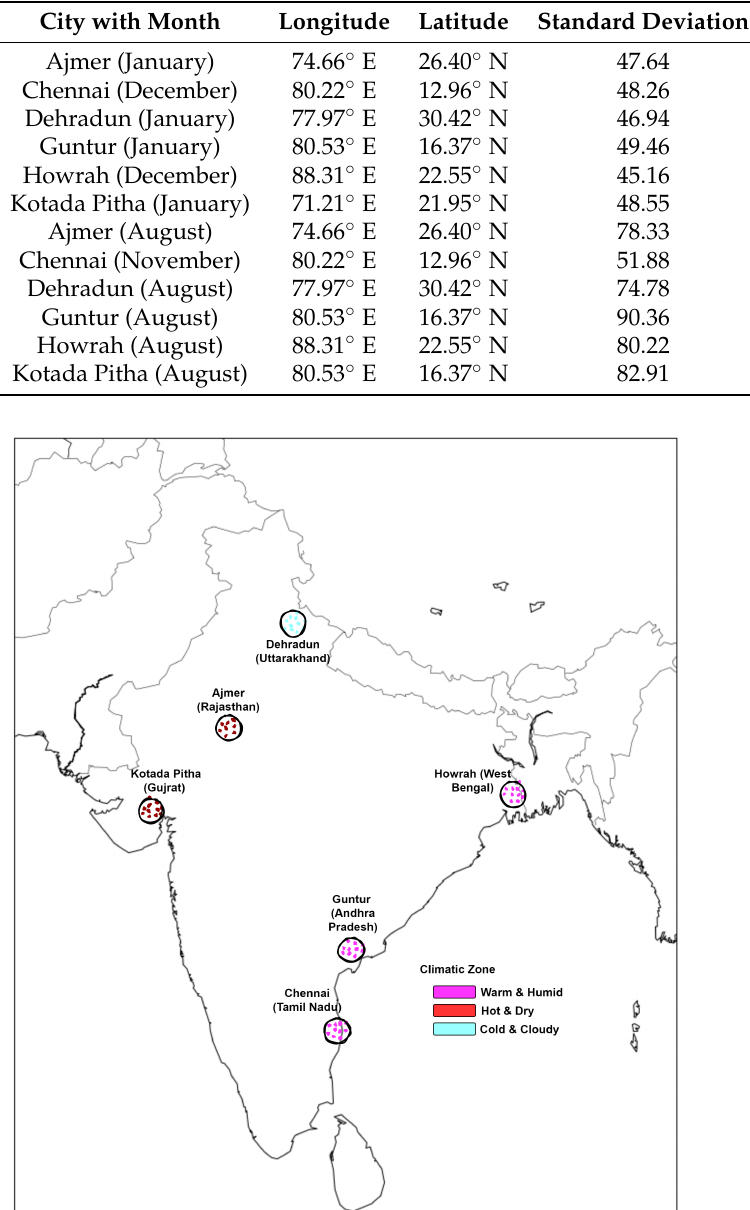
Table 3. Description of the data.